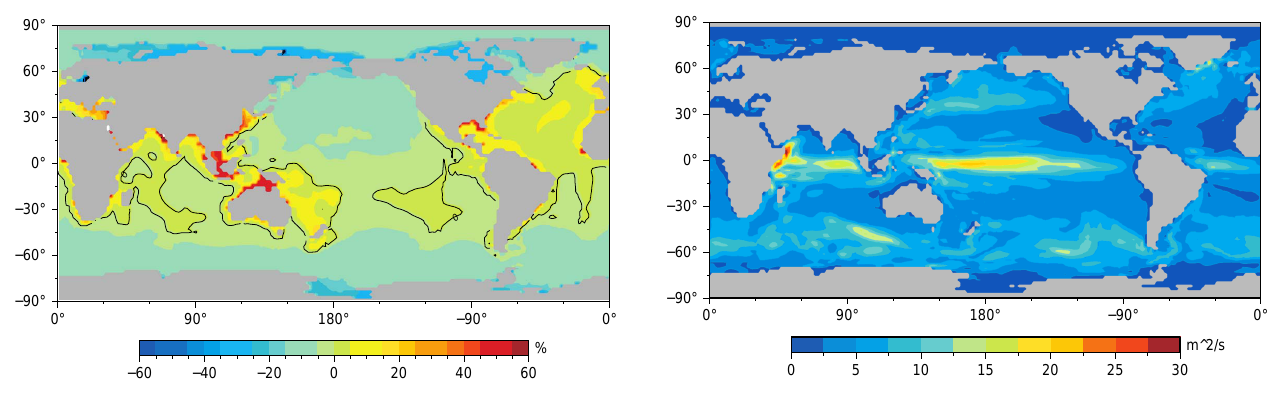
Figure 6. Relative difference between depth-mean conductivity used in the spatially variable conductivity experiment and globally constant conductivity of 3.5Sm − 1 used in the constant conductiv- ity experiment. The black contour line highlights the transition from positive to negative values.